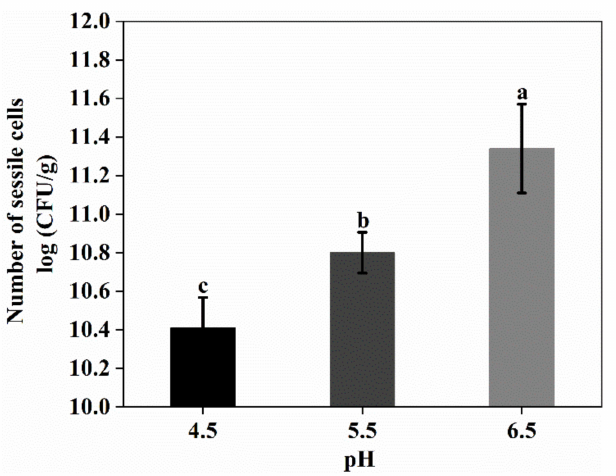
Figure 7. The effect of pH on the number of sessile cells. Significant differences ( p < 0.05) are indicated by different letters (a, b, and c).